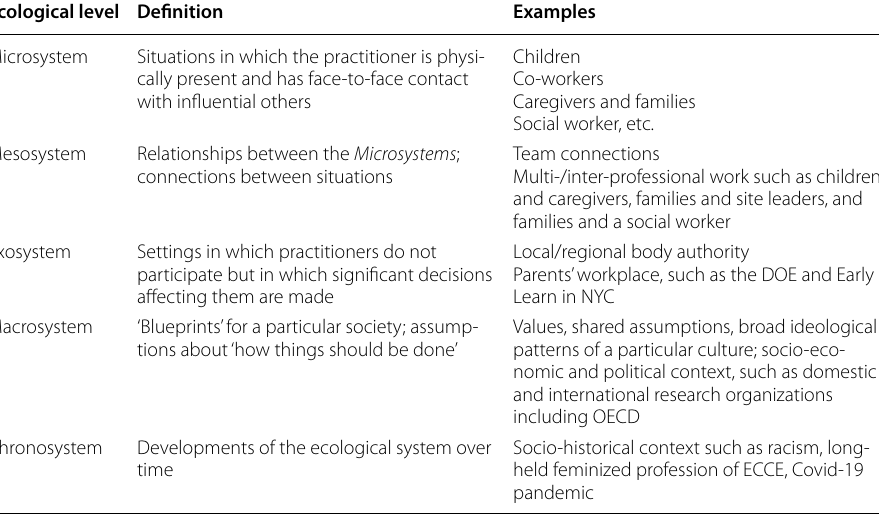
Table 1 Definitions of ecological system terms as used in this paper. Adapted from Dalli et. al. (2012, p.